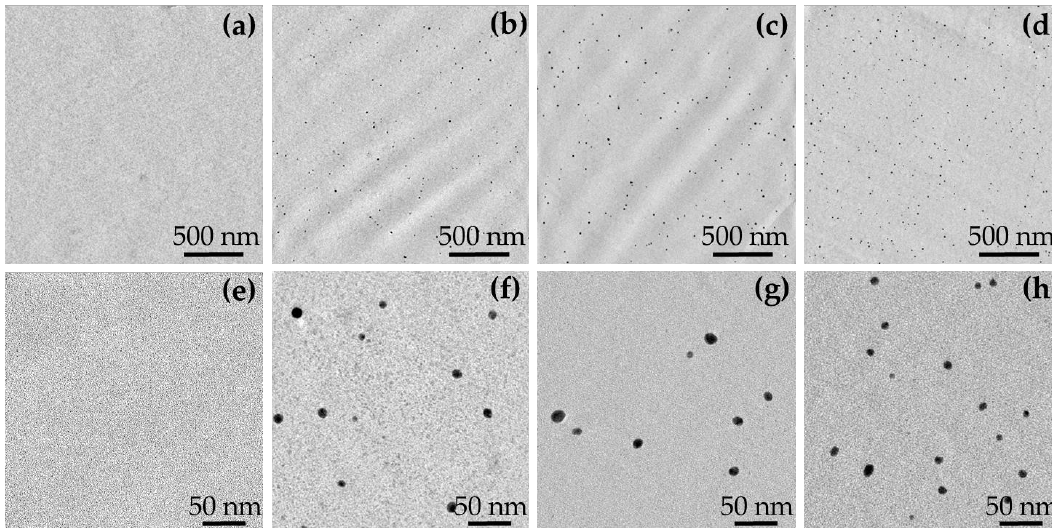
Figure 3. Transmission electron microscopy (TEM) micrographs at two different magnifications of “Unfilled” ( a , e ); “AgAcr 1%” ( b , f ); “AgAcr 2%” ( c , g ); and “AgMAcr 1%” ( d , h ); as representative.